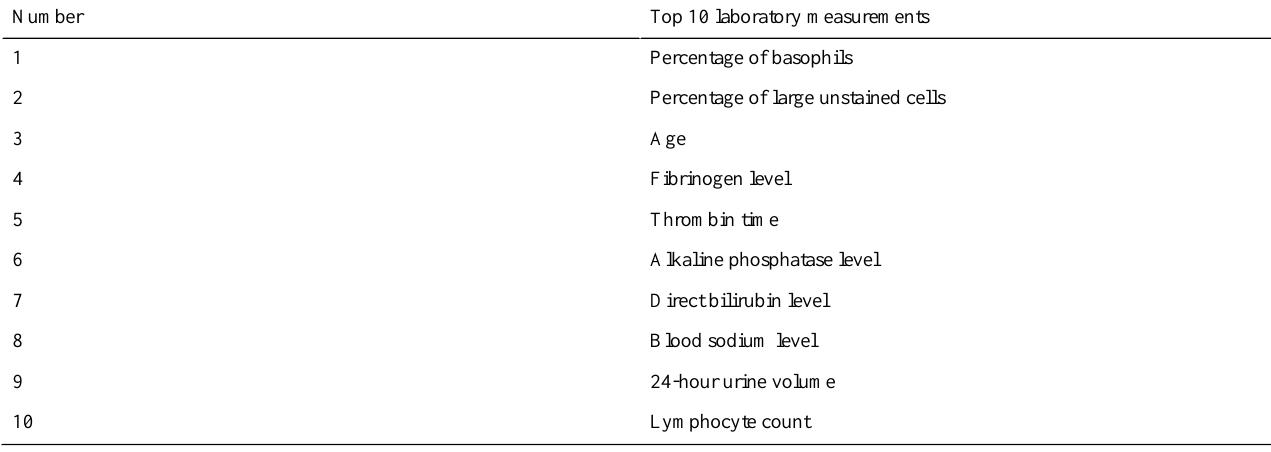
Table 2. Top 10 laboratory measurements related to the diagnosis of the cause of fever of unknown origin.